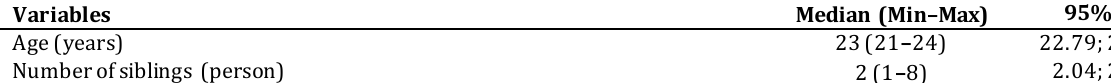
Table 3. Distribution Frequency o f Participants’ Moral Sensitivity (n =162) Variable